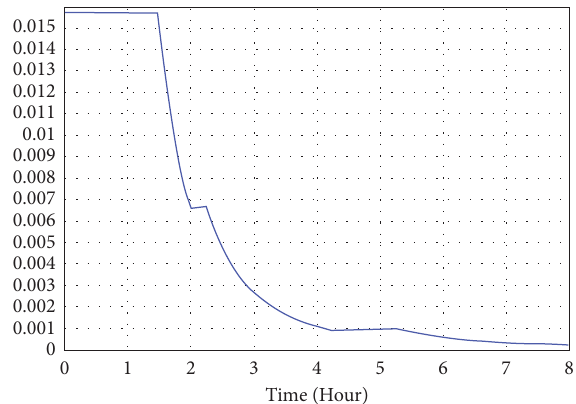
Figure 9: HEP for operation complexity according to working